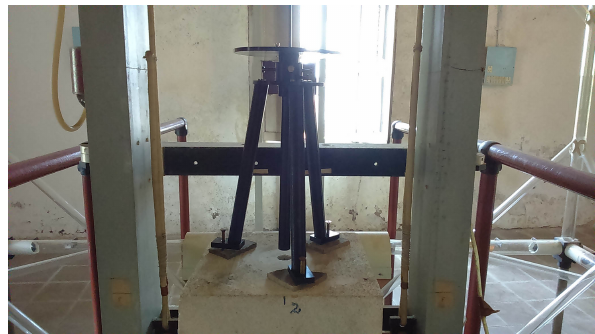
Figure 8. The sensor to be calibrated is mounted on a non-magnetic table referred to as the test stand, which is placed at the centre of the Helmholtz cage.